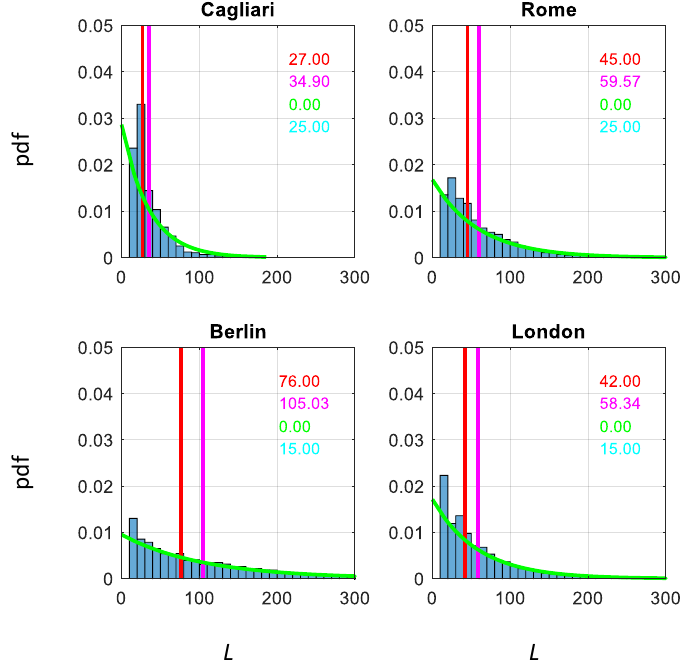
Figure 9. Pdf (ordinates) of L (m) (abscissa) for each of the case studies; the red line highlights the average value, the magenta line the median value, the green line the best-fit exponential distribution; on the legend, in red the average value, in magenta the median value, in green the most probable value of the best-fit distribution and in cyan the most probable value of the data.